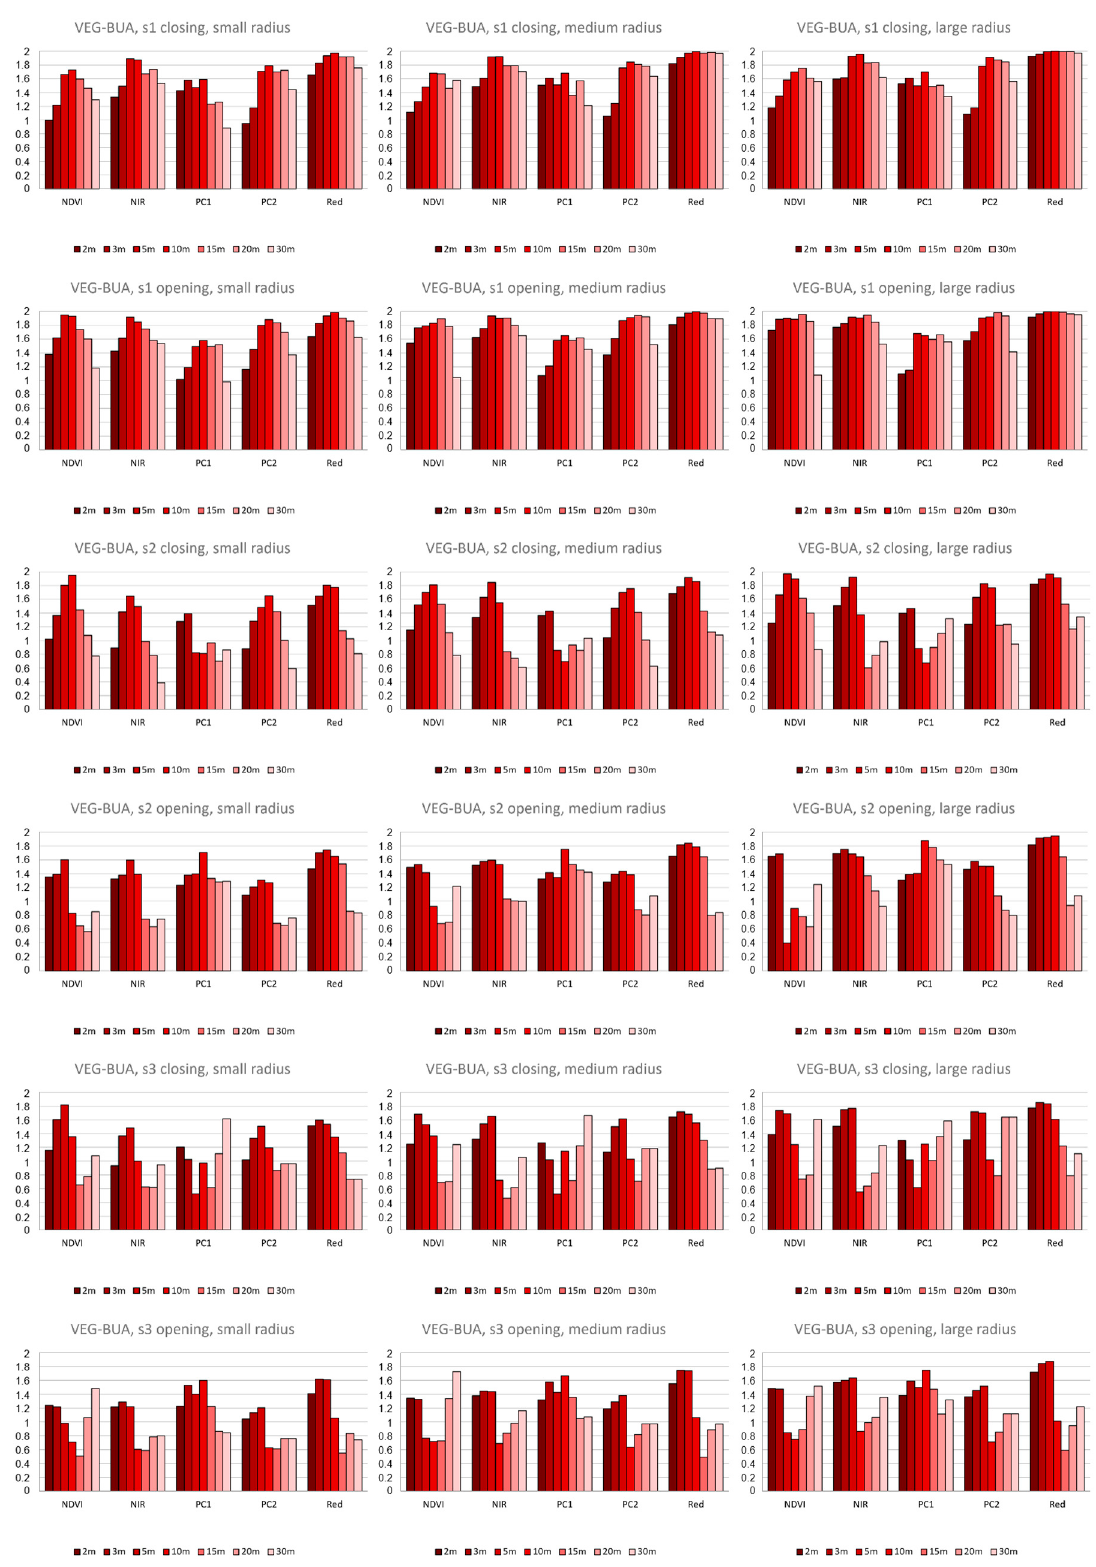
Figure 7. J–M distance diagrams for test fields for the low vegetation/built-up area class pair (VEG/BUA).